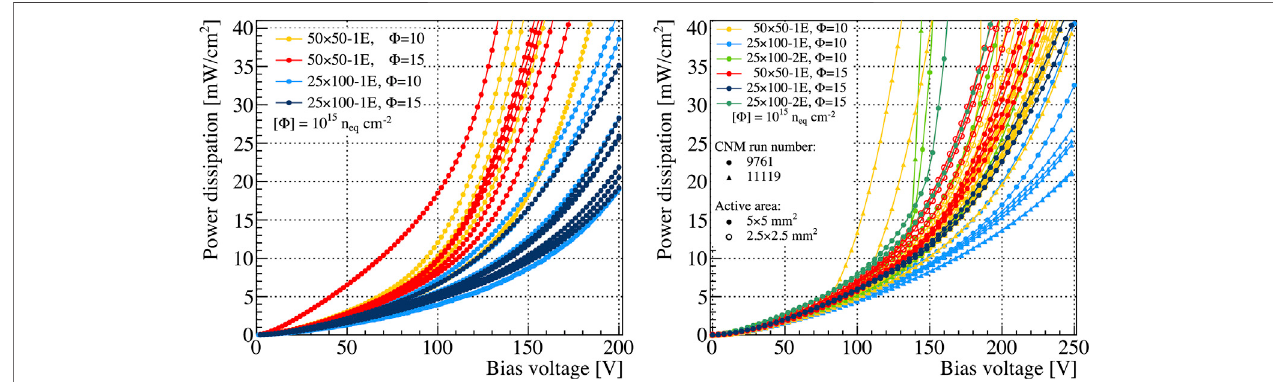
FIGURE14| PowerdissipationasafunctionifthebiasvoltageforFBKdiodes (left) andCNMdiodes (right) withdifferentpixelgeometriesafterneutronirradiation at JSI, Ljubljana.